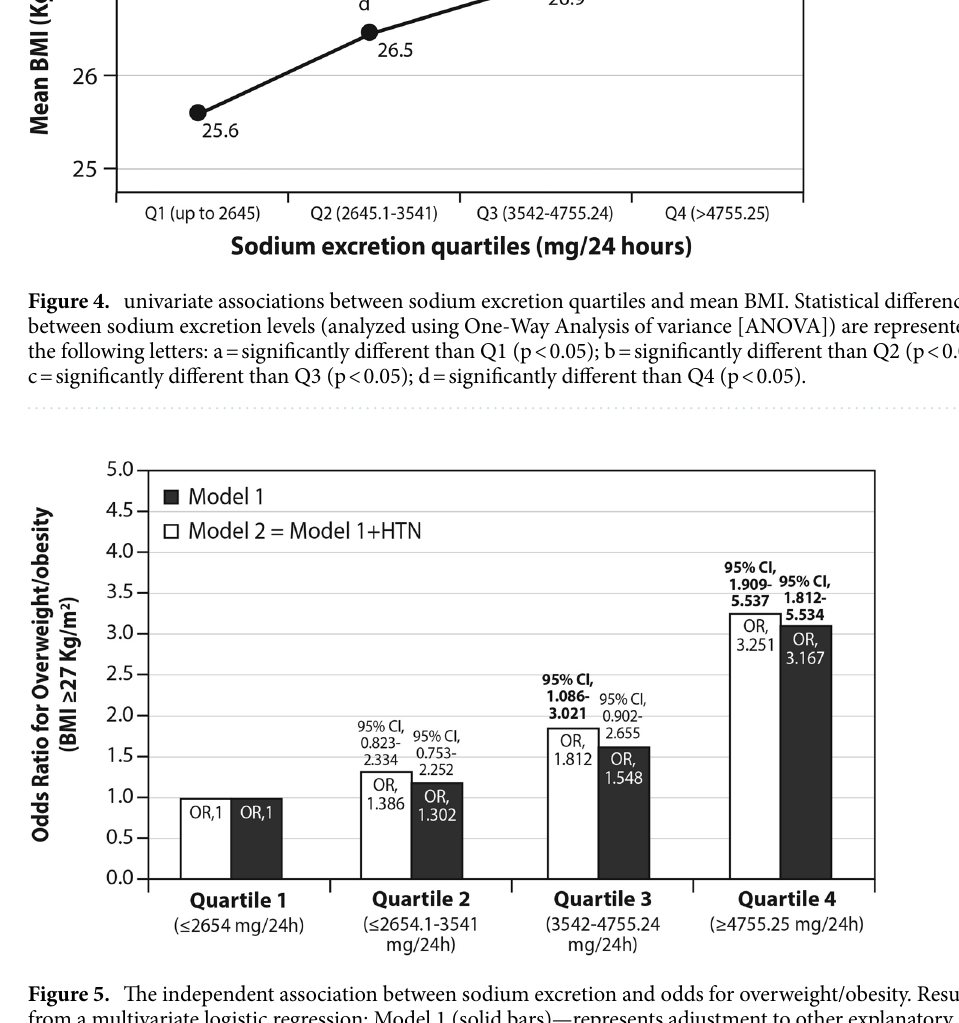
overweight or obese, but the difference was statistically significant only when compared to non-obese hyperten- sive subjects (Fig. 6B). Similar results are seen if the interviewees are categorized into non-obese vs. obese (less than or ≥ 30 kg/m 2 ) (Figure S4).